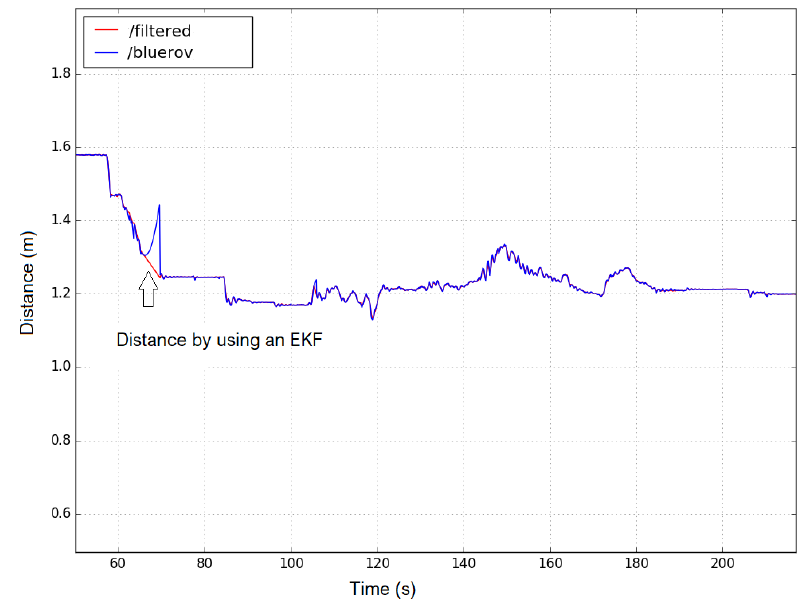
Figure 15. Distance between BlueROV robot follower 2 and the BlueROV robot leader. Figures 16 and 17 show the control signals of the robot followers 1 and 2. The robots are controlled in the x (a blue line / ux / data ) and y (a red line / uy / data ) axes, respectively, to change the distance between the follower and the leader robot. We can observe that the rotation control signal / up / data of the robots (the light blue line) has a large change because of the limitation of the accuracy of the sensors. However, these control signals can also converge when the distance between the robots reaches the desired value.